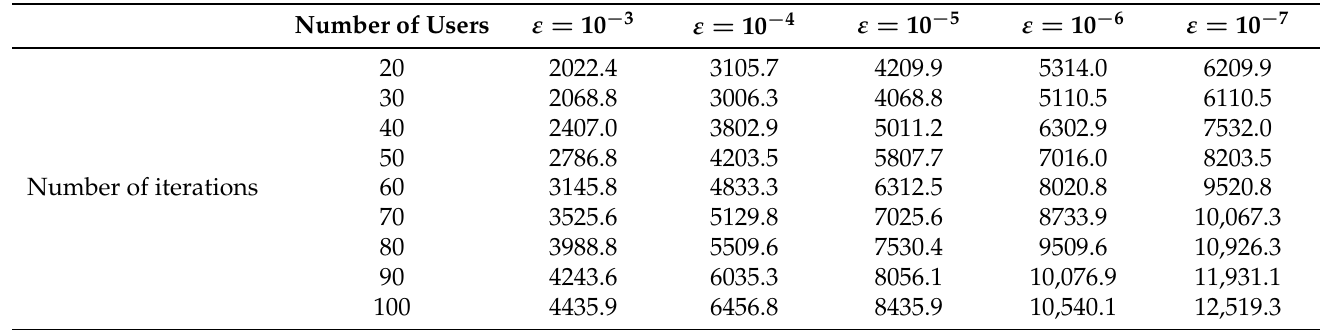
Table 1. Average time to convergence for different ε . When ε R m is larger than the gap between demand and supply, we define the number of iterations as convergence. In comparison, the smaller the parameter ε , the larger the gap between supply and demand, so more iterations are required. For instance, if ε = 10 − 3 , the time to convergence is 2000–4000 in most cases, if ε = 10 − 7 , the time to convergence is 6000–12,000.